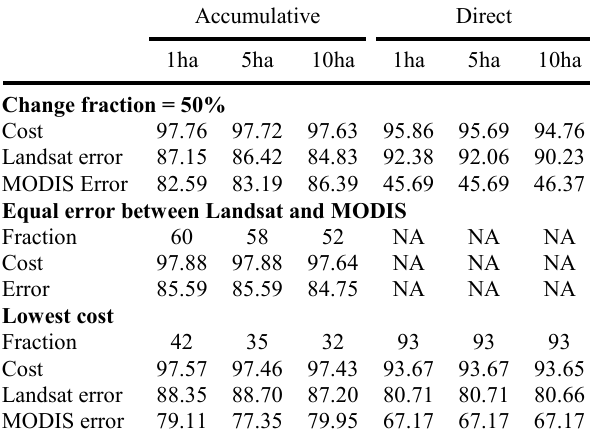
Table 8. Cost, fraction and error statistics (all in percent) for MODIS versus Landsat change